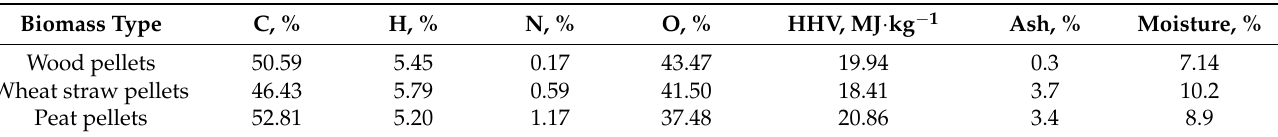
Table 1. Proximate composition and higher heating value (HHV) of commercial wood, wheat straw, and peat pellets (on dry basis).